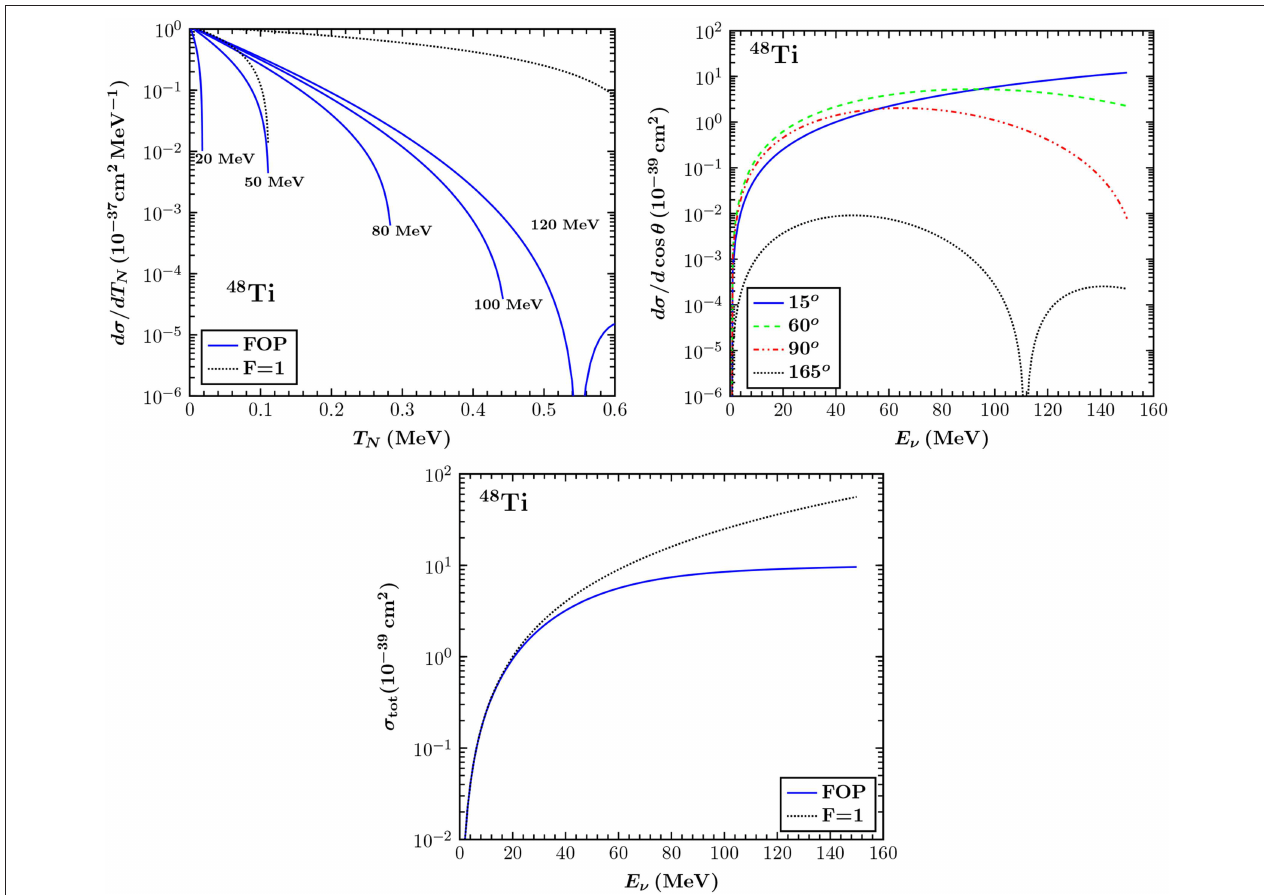
FIGURE 2 | (Upper Left) The differential cross section d σ/ dT N in terms of the nuclear recoil energy T N for different incident neutrino energies. The results are compared to the case of point-like nucleus ( F 1) for E ν 50 and E ν 120 MeV. (Upper Right) The differential cross section d σ/ d cos θ as a function of the = = = incoming neutrino energy E ν , for different scattering angles (for backward scattering the cross section vanishes). (Bottom) The CE ν NS cross section σ tot as a function of the neutrino energy. An asymptotic behavior is found at neutrino energies E ν 80 MeV or higher. Taken from Papoulias ≥